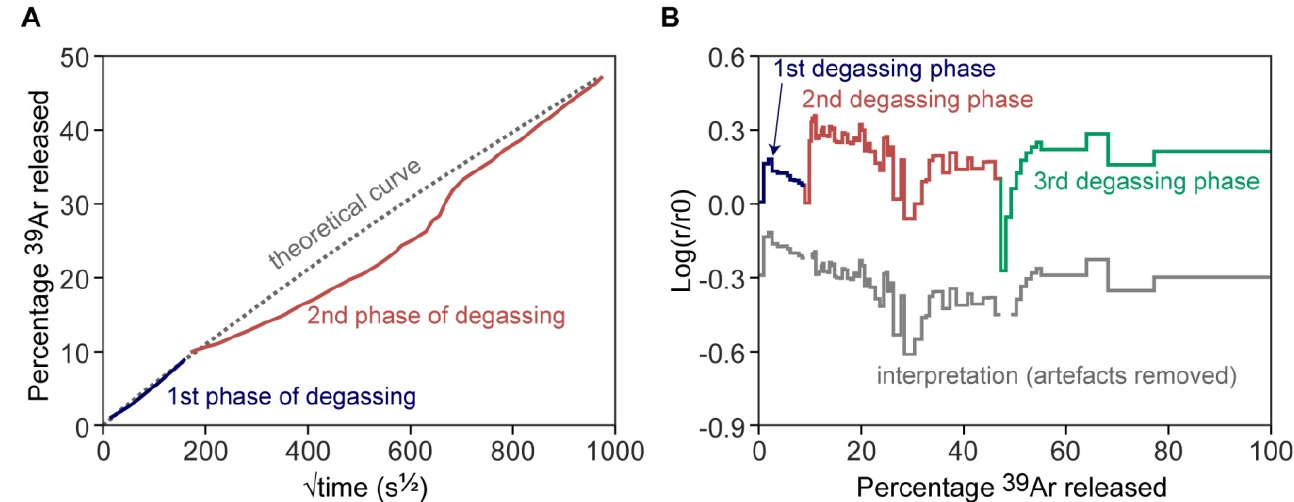
Figure 8. Data from Kung and Villa (2021) [58] obtained by in-vacuo degassing of alkali feldspar from Itrongay, Madagascar. The experiment included 3 heating phases where the 1st and 2nd phases were heated at 888 ◦ C, while the 3rd phase was step-heated between 1024 ◦ C and 1449 ◦ C. The analysed fragment was removed from the spectrometer between each heating phase. ( A ) 39 Ar degassing rates during the first 2 phases of heating compared to a theoretical curve for a single domain with constant diffusivity (see [58], for details). The departure of the experimental from the theoretical curve was interpreted to reflect changes in diffusivity through time. ( B ) log(r/r0) plot for all 3 heating phases assuming an activation energy of 241.9 kJ/mol (derived from the slope defined by heating steps 76 and 77). The topology of the log(r/r0) plot for the first 2 phases of heating does not depend on the activation energy because the heating temperature remained constant. Abrupt changes in log(r/r0) coincide with reloading of the analysed fragment into the spectrometer and thus may represent an analytical artifact. We have attempted to correct for these artifacts (grey line) by (i) arbitrarily shifting the plot segment of the 1st phase of heating by − 0.3 log units (to avoid overlap with the original data, rendering it easier to see), and (ii) shifting the plot segments of the 2nd and 3rd phases of heating such that the second heating step in each of them yields the same log(r/r0) value as the final heating step in the preceding phase of heating. Note that the effective diffusion length decreases until ~30% of 39 Ar has been released, after which it increases. This trend in log(r/r0) is visible in the log(r/r0) plot with and without artefacts, and is consistent with observation that the heated fragment crumbled into dozens of euhedral cleavage fragments after the 2nd phase of heating [58].